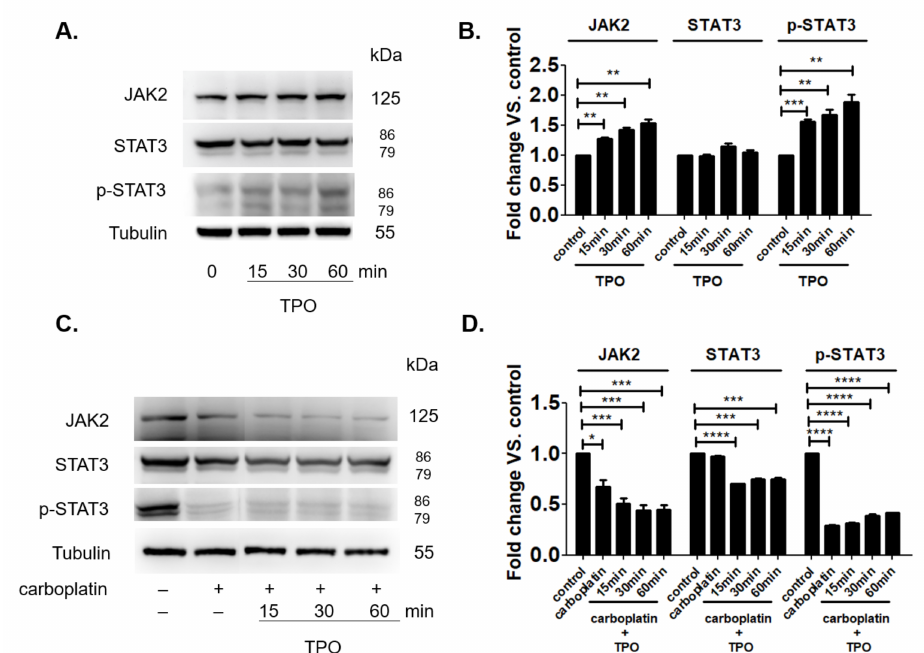
Figure 6. TPO failed to activate STAT3 signal pathway of MEG-01 cells in the presence of carboplatin. ( A , B ) MEG-01 cells were treated by TPO for 0–60 min and the expressions of JAK2, STAT3 and p-STAT3 were determined by the western blot method. ( C , D ) MEG-01 cells were pretreated with carboplatin for 24 h, then by TPO for 0–60 min and the expressions of JAK2, STAT3 and p-STAT3 were determined by western blot method. (* p -value < 0.05, ** p -value < 0.01, *** p -value < 0.001, **** p -value <